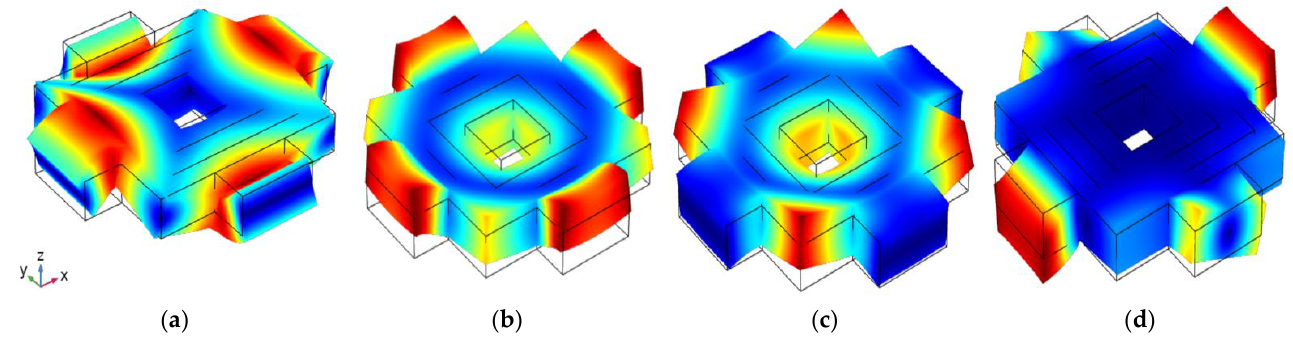
Figure 5. Vibration modes of the third and fourth bandgap edges: ( a ) Point E; ( b ) Point F; ( c ) Point G; ( d ) Point H.